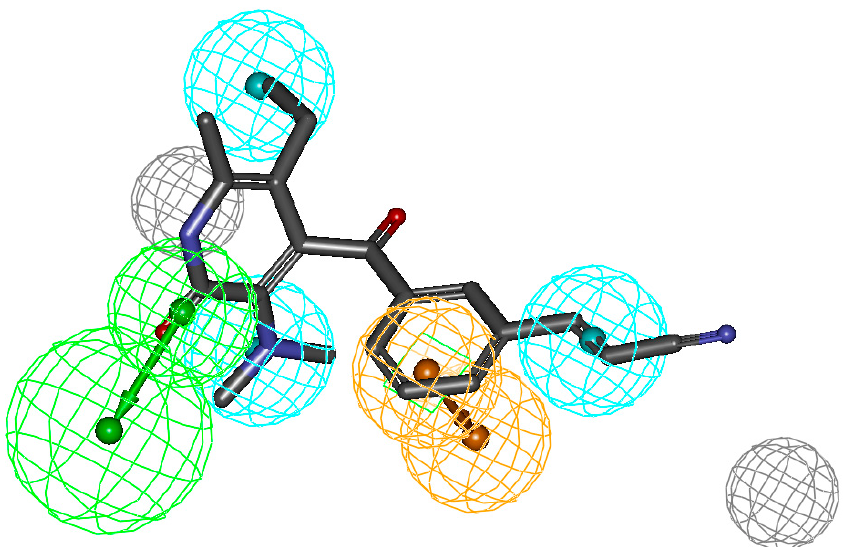
Figure 2. Pharmacophore mapping of the most active ( 27 ) compound from the training set predicted correctly. The figure indicates the mapping of all groups essential for receptor binding. Reported activity: 0.0004 μ M, estimated: 0.0009 μ M, and fit value: 13.45.